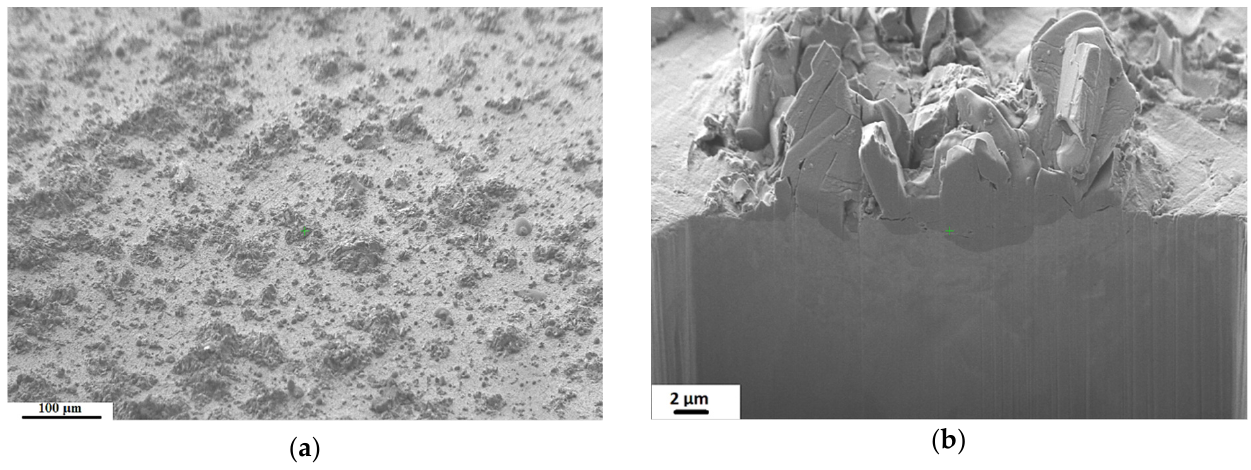
Figure 8. SEM images of Ti 3 AlC 2 sprayed particles at ~730 m/s on SS : ( a ) top view, ( b ) FIB cross-section.